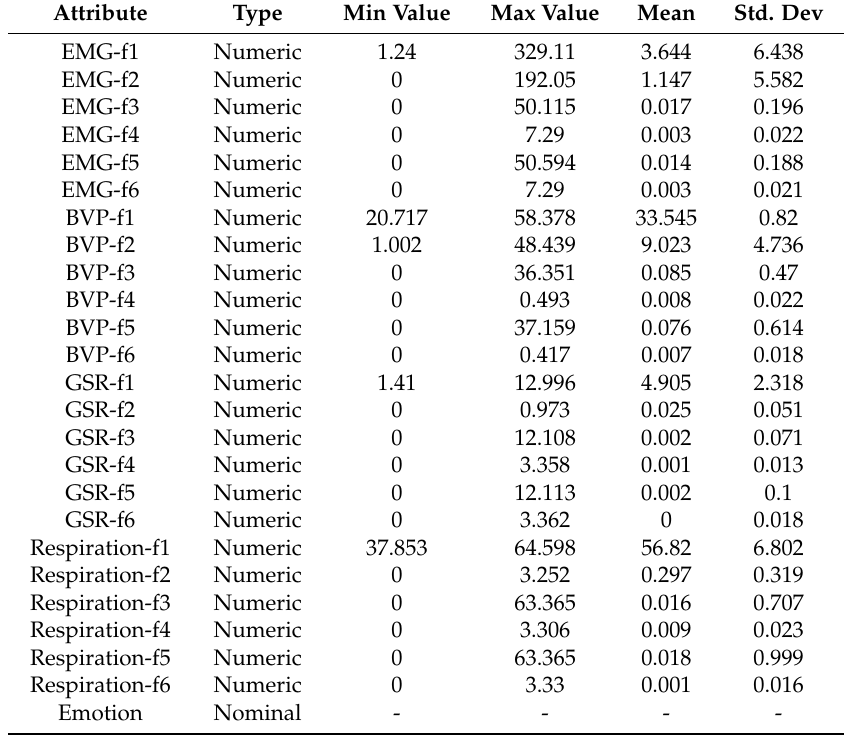
Table 7. Profile information of dataset used for emotion detection. Min Value and Max Value are the Minimum and Maximum values in the dataset. Std. Dev is the standard